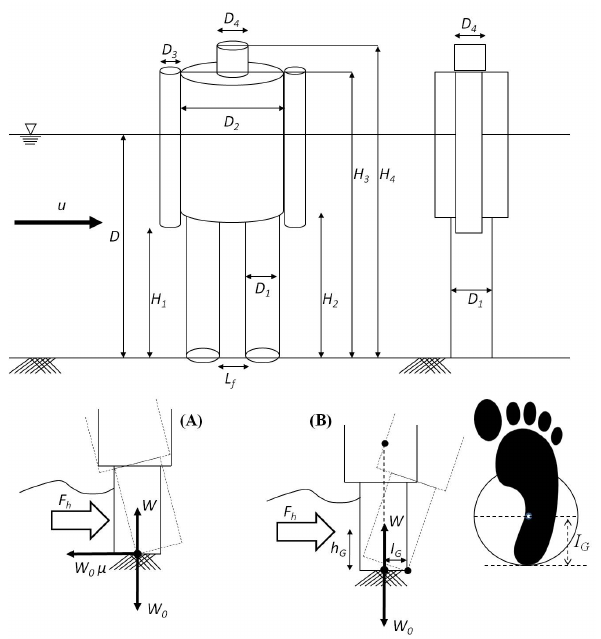
Fig. 10. Schematic description of human body and the type of fall condition: (A) Slipping fall type, and (B) tumbling fall type.